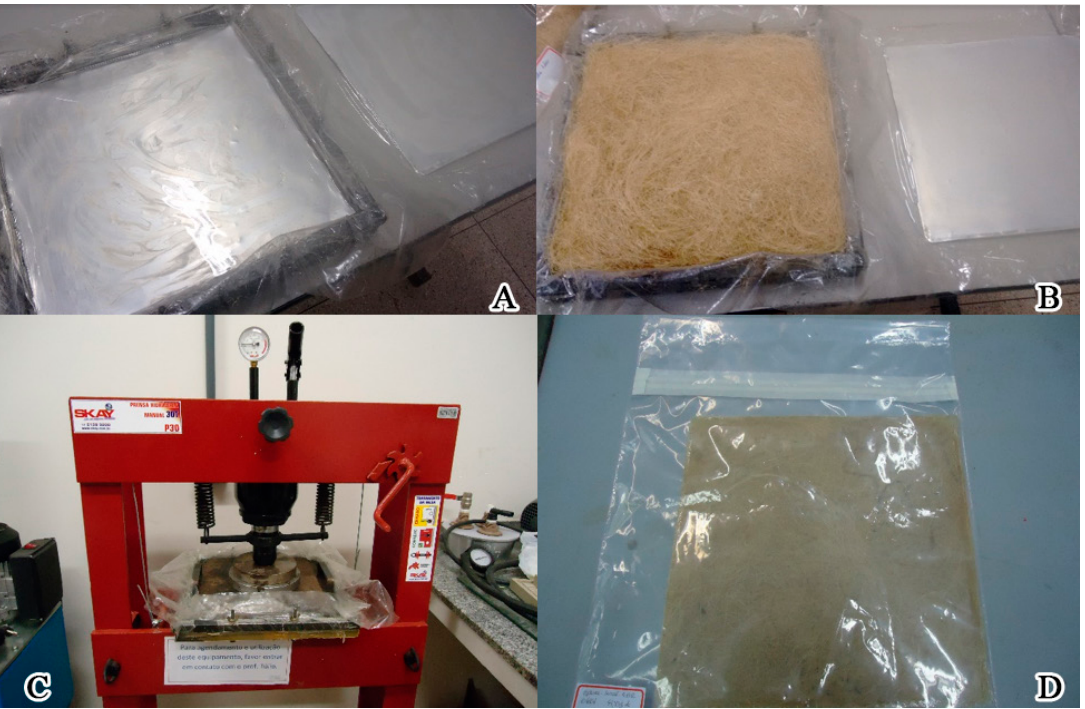
Figure 1. Manufacturing process steps: a) mould with aluminium surfaces covered by resin; b) sisal embedded with epoxy inside the mould; c) compaction pressure; d) composites sealed with bags (post-curing